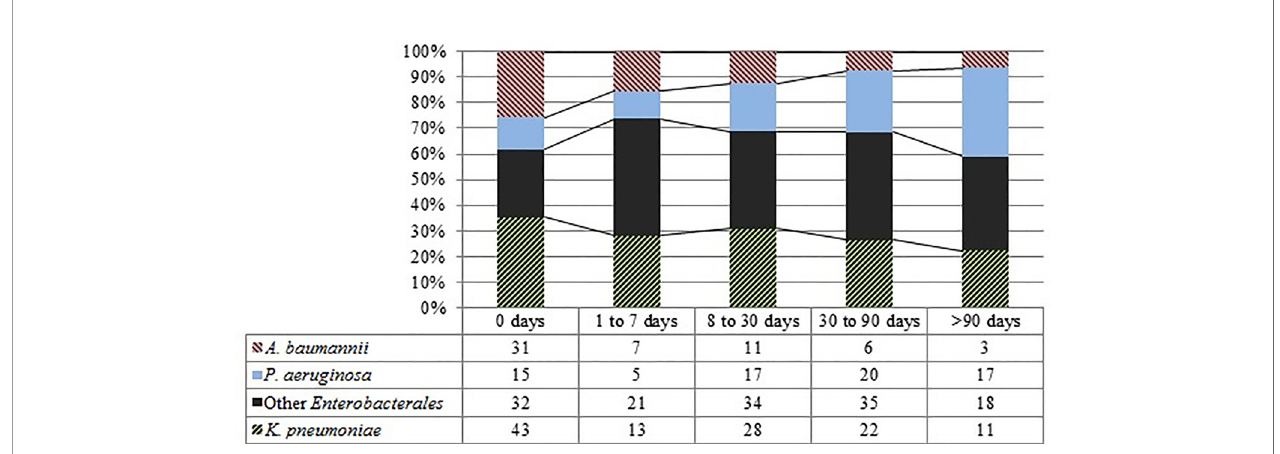
FIGURE 4 | Total and relative amounts of species